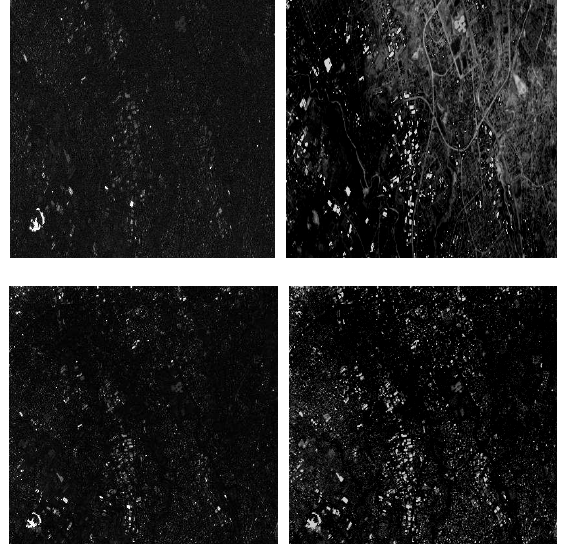
Figure 4. Example of comparison of RX global anomalies (left) and DATB anomalies (right) by K-Means algorithm from MASTER image of San José. The anomalies have been classified in five cluster: error, background 1, background 2 in withe colour; strong anomalies in black and smooth anomalies in